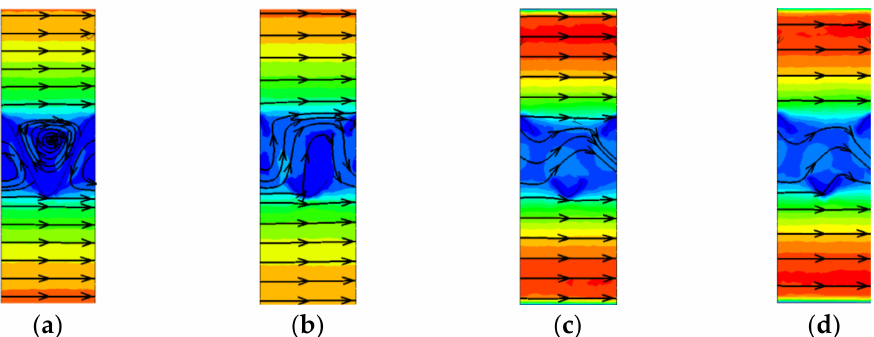
Figure 13. Velocity and streamline distributions on the middle cross section of the hole in four cases at Re = 27,900. ( a ) BP case; ( b ) one-circle case; ( c ) two circles case; ( d ) three circles